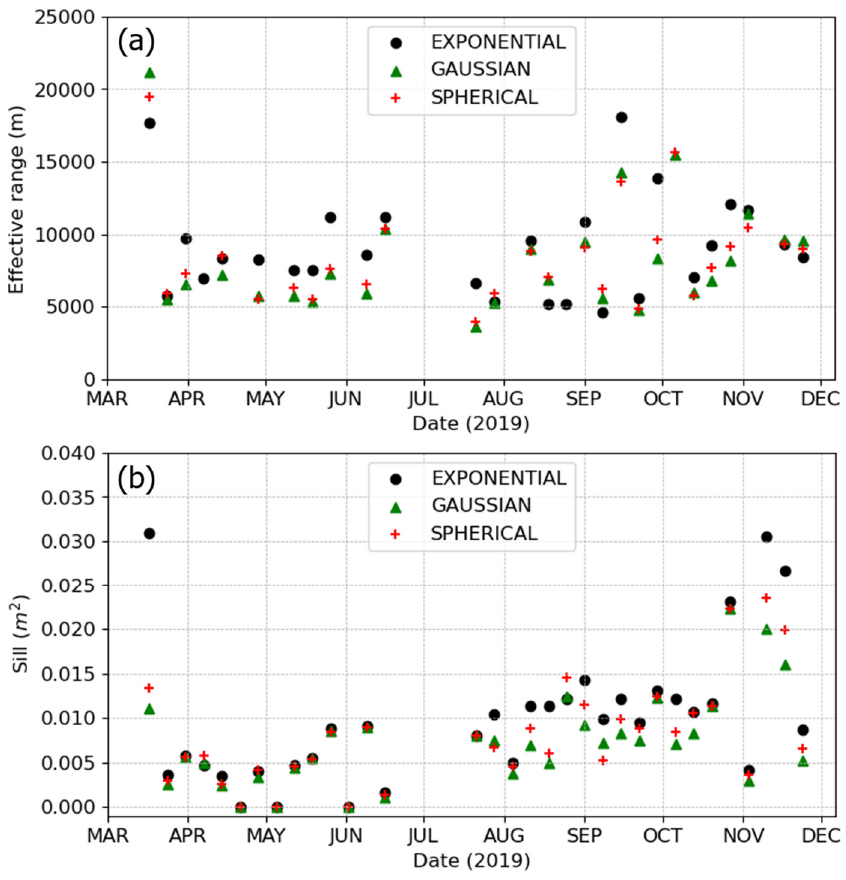
Figure 8. Temporal variations of variogram factors: ( a ) effective range and ( b ) sill.